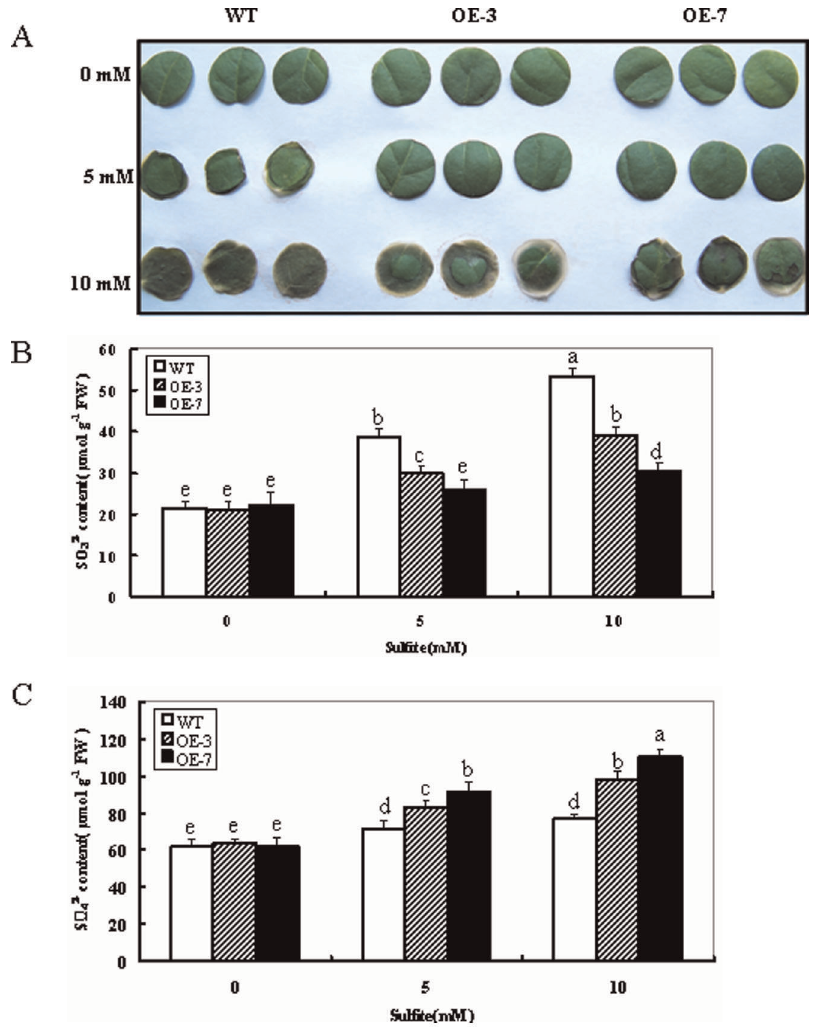
Figure 3. Responses of wild-type and ZmSO over-expression tobacco plants to toxic levels of sulfite. (A) Toxic effect of Na 2 SO 3 (5 and 10 mM) on leaf discs from 8-week old wild-type and OE lines. After 16 h treatment, Leaf discs of wild-type plants showed higher chlorosis and damage than OE lines (OE-3 and OE-7). (B) Sulfite concentration in Na 2 SO 3 treated leaves from wild-type and OE plants. (C) Sulfate concentration in Na 2 SO 3 treated leaves from wild-type and OE plants. In both (B) and (C), leaf discs were separately sampled and washed three times with distilled water after exposure of the plants to 0, 5 and 10 mM Na 2 SO 3 for 16 h. The leaves were then used for sulfite and sulfate contents analysis. Data are the means of three replicates ( 6 SE). Means denoted by the same letter did not significantly differ at P , 0.05. The data are from one of three different experiments that yielded essentially identical